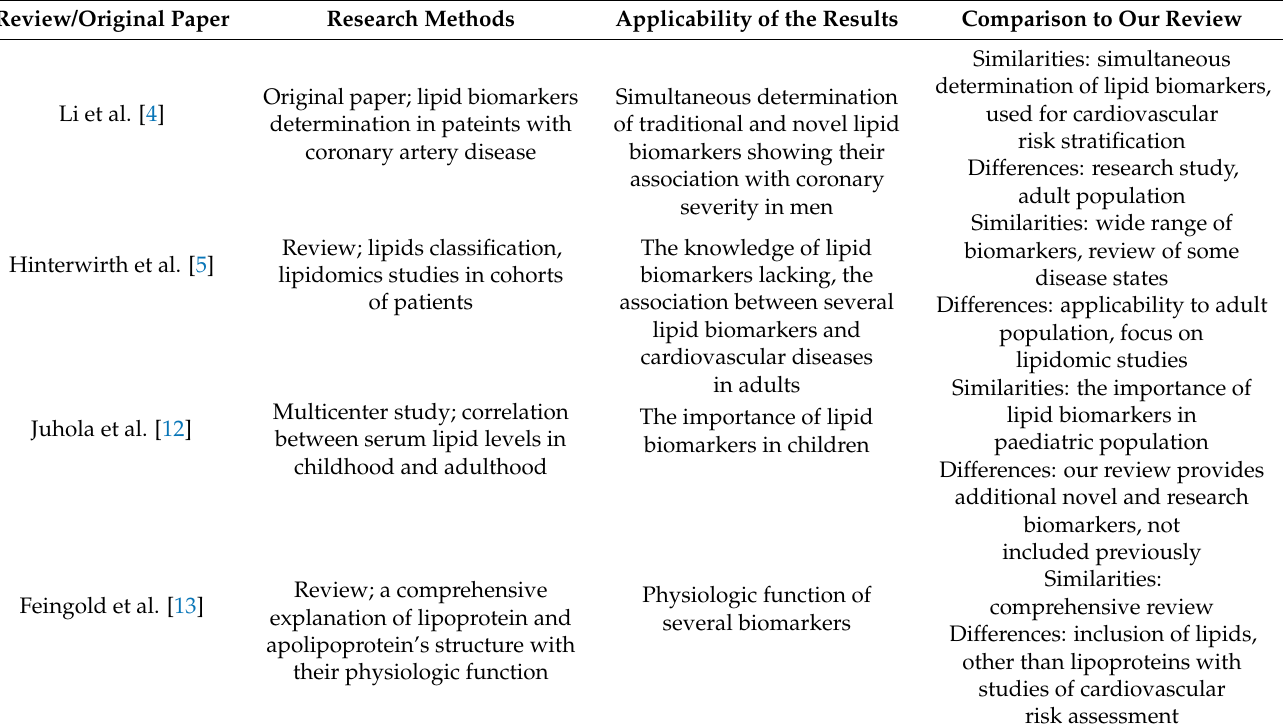
Table 1. Summary of most important previous studies, classified by different criteria and compared to our